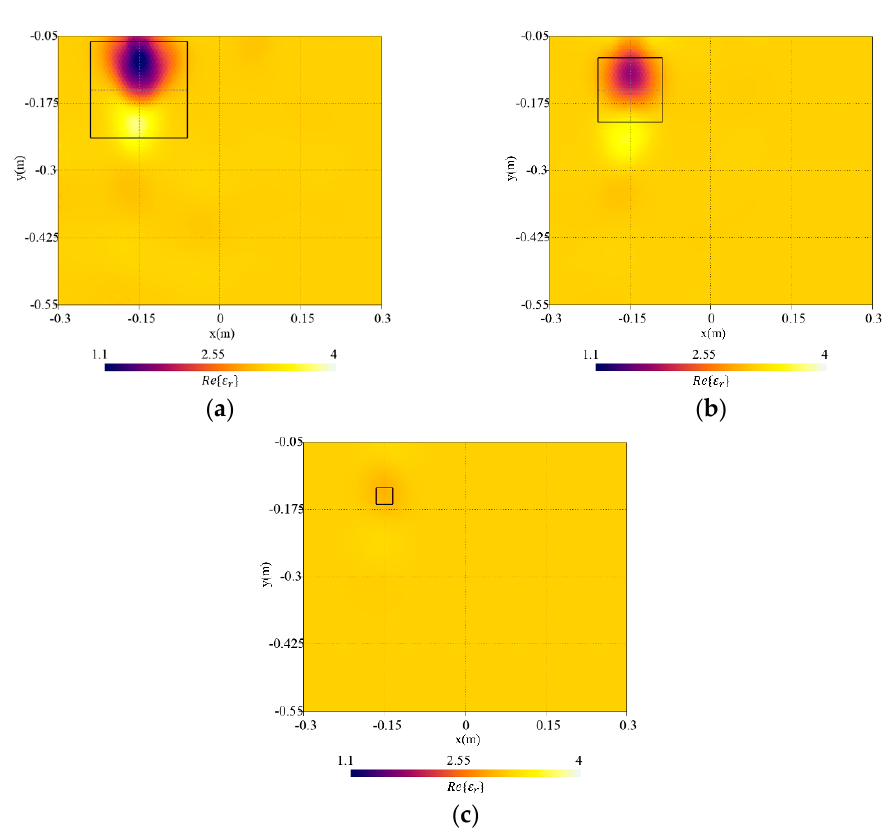
Figure 7. Reconstructed distribution of the real part of the dielectric permittivity, Re { ε r } , in the investigation domain R together with a square box indicating the shape of the actual target. Target with side length ( a ) l t = 18 cm, ( b ) l t = 12 cm, and ( c ) l t = 3 cm.